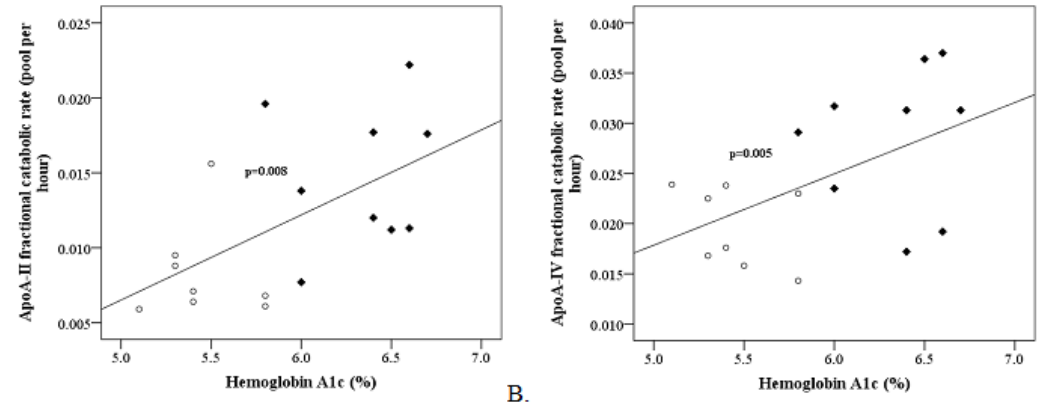
Figure 2. Association of hyperglycemia with the turnover rates of Apo-II and ApoA-IV. As hemoglobin A1c levels are increased, ApoA-II and ApoA-IV half-lives are decreased. Panel ( A ): Hemoglobin A1c levels and ApoA-II fractional catabolic rates are strongly correlated (slope = 0.005 [CI 0.0020, 0.009]). Panel ( B ): Hemoglobin A1c levels predict ApoA-IV kinetics (slope = 0.008 [CI -8.7e − 05 , 0.013]). Open circles and close rhombus signs represent healthy controls and individuals with type II diabetes,